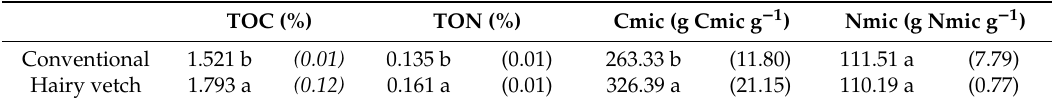
Table 2. E ff ect of the hairy vetch mulching on the soil TOC (total organic carbon), TON (total organic nitrogen), microbial carbon (Cmic), microbial nitrogen (Nmic) at vegetable crops harvesting.